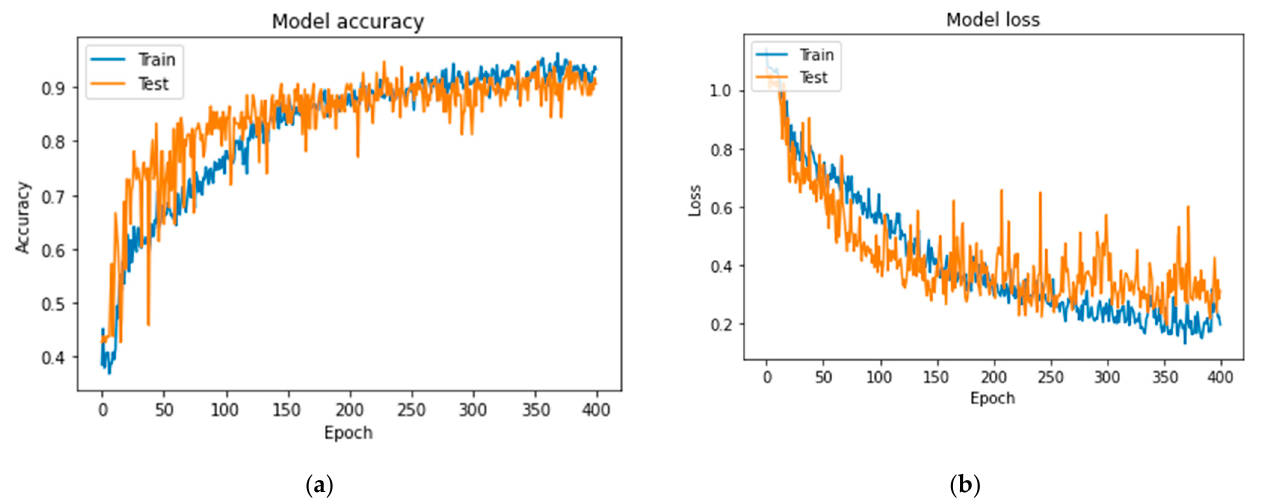
Figure 7. Plots demonstrating the best RGB-CNN for the CAD classification problem: ( a ) accuracy; ( b ) loss.